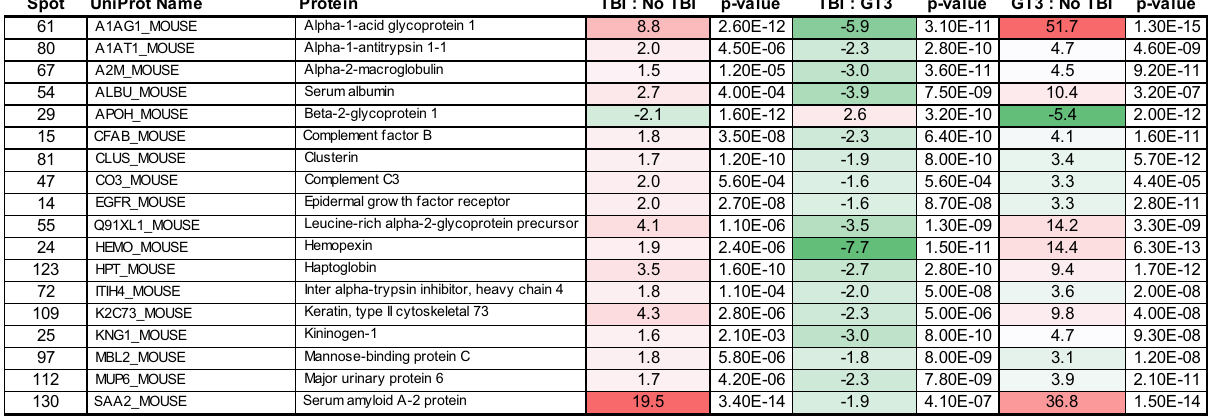
Figure 4. Serum proteins reflecting a change in expression in response to TBI and reversal with prophylactic treatment of GT3. Protein expression ratio changes are presented with a color scale to indicate increase (red) or decrease